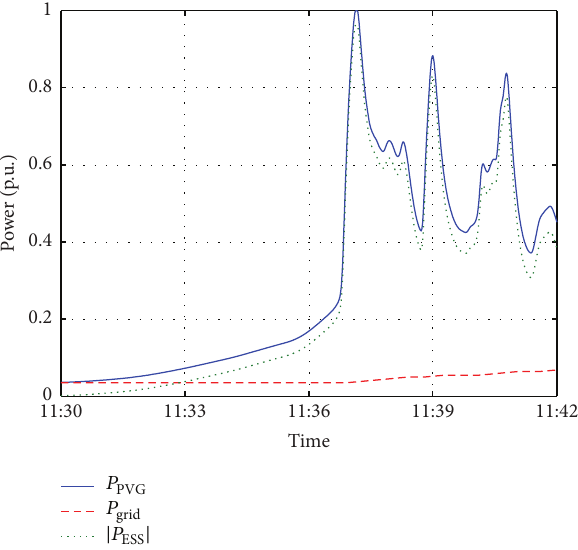
Figure 10: Output power of the 2.2 MWp PV generator, grid feed-in power, and the absolute power of ESS during the formation of the maximum ESS power requirement on 07.06.2012 while complying with RR limit of